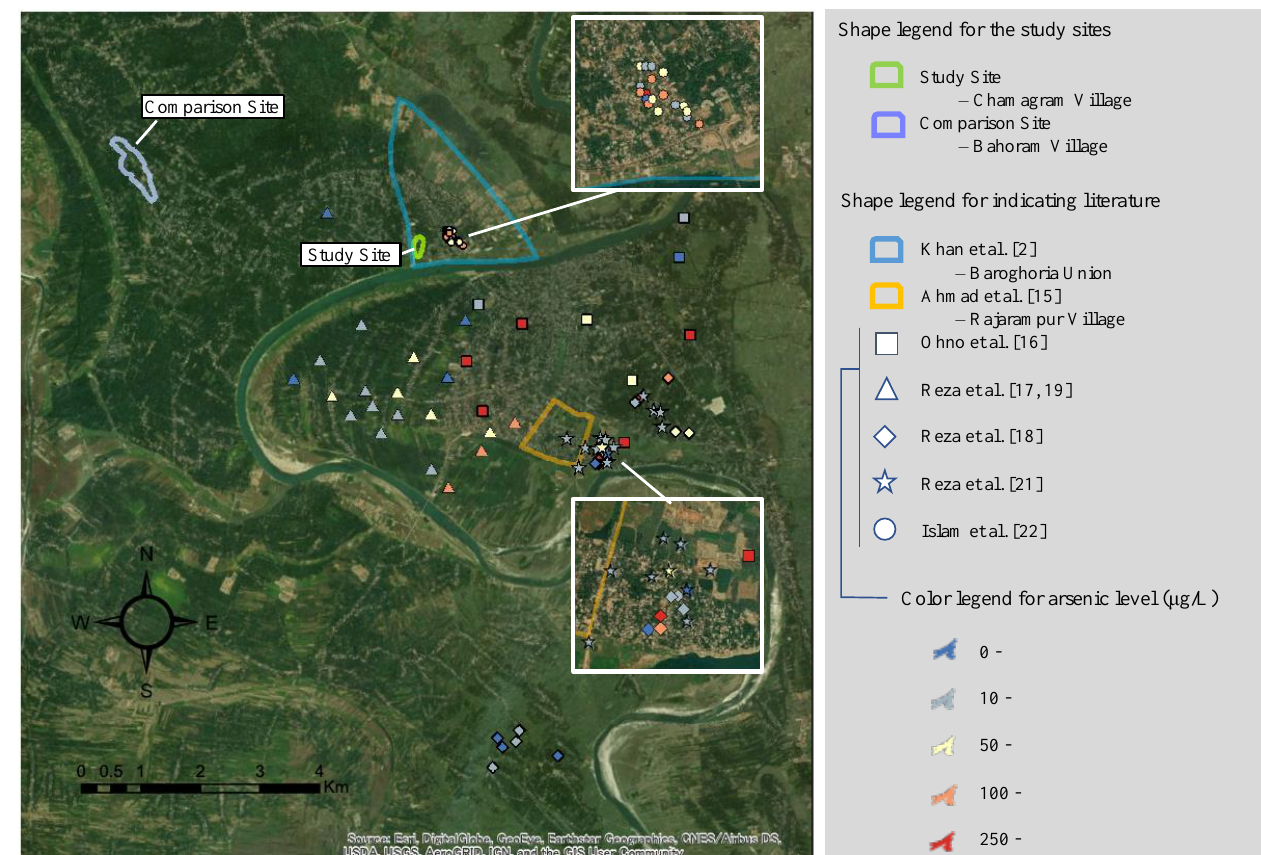
Figure 1. Map of tested tube-well locations and field-testing sites.